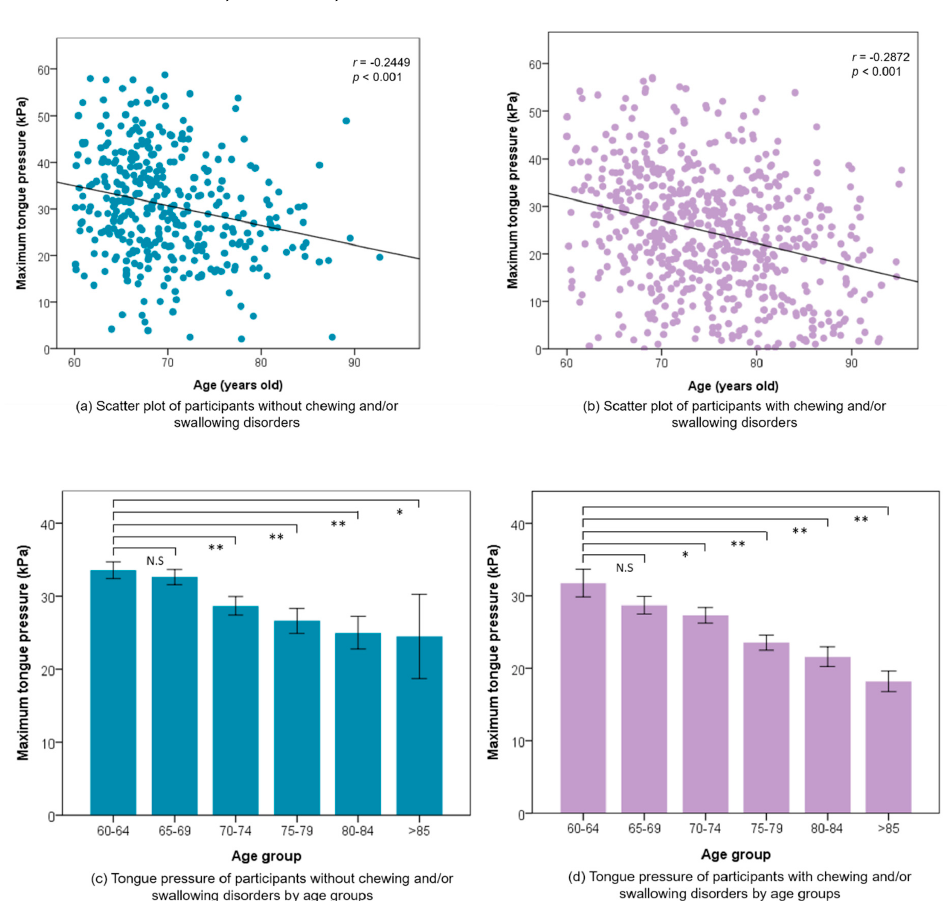
Figure 4. Correlation between maximum tongue pressure and age of both participants ( a ) without and ( b ) with chewing and/or swallowing difficulties. Tongue pressure of participants ( c ) without and ( d ) with chewing and/or swallowing dif- ficulties by age groups. Each bar shows the mean value and standard error. * p < 0.05, ** p < 0.01. N.S.: non-significance. In order to better understand the participants, we further compared the dietary hab- its between the NCSD and CSD groups, as shown in Table 3. Higher TP values of CSD participants had a statistically significant benefit with their independent ability to eat, var- ious types of diet, and shorter duration of meal time (all p < 0.050) while eating a meal. As TP decreased, CSD participants obviously felt that they needed to take longer to eat a meal than before ( p = 0.006).